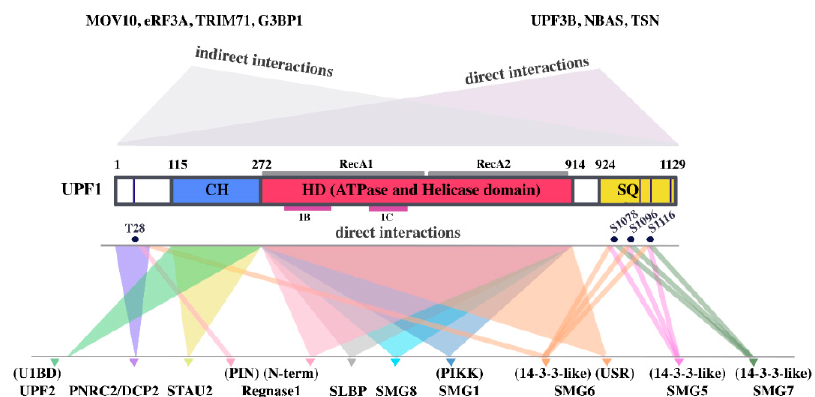
Figure 1. Functional up-frameshift factor 1 (UPF1) domains and their interactions with other proteins. CH: cysteine–histidine-rich domain, HD: helicase and ATPase domain with the RecA1, RecA2, 1B and 1C subdomains indicated by gray and magenta lines, respectively; SQ: serine–glutamine-rich domain. Validated phosphorylated amino acids with a function in protein–protein interactions, are shown in dark blue circles. Experimentally validated binding regions of UPF1-interacting UMD e ff ector proteins are indicated below UPF1. UPF1-binding domains of UPF1-interacting proteins are indicated above the protein names. Proteins, that bind to UPF1 at as yet unknown sites are listed in the upper right corner. Proteins, that interact with UPF1 indirectly via RNA or other proteins are listed in the upper left corner.